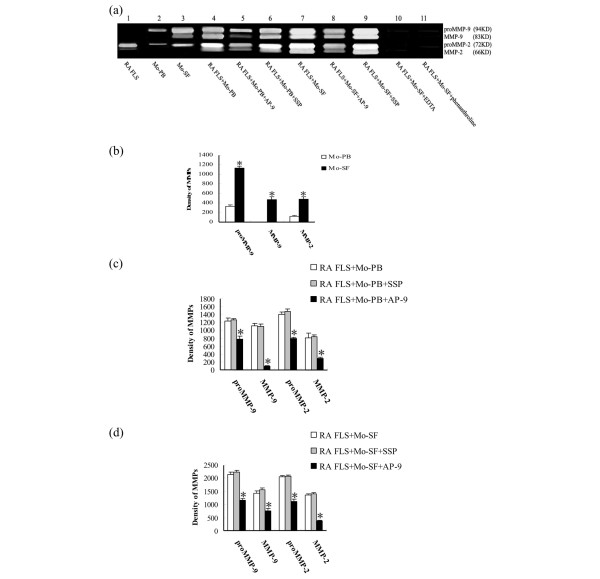
Gelatin zymography of culture medium conditioned by fibroblast-like synoviocytes (FLS) and monocytes/macrophages. Cells were cultured in serum-free media for 24 hours, and the conditioned media were collected and analyzed for matrix metalloproteinase (MMP) activity by gelatin zymography. (a) Secretion and activation of MMPs in rheumatoid arthritis (RA) FLS, monocytes/macrophages, RA FLS co-cultured with monocytes/macrophages, and in co-cultured cells treated by AP-9 or SSP, and ethylenediamine tetraacetic acid or phenanthroline. Top two bands, MMP-9 gelatinase; lower two bands, MMP-2 gelatinase. (b) The value of proMMP-2 and MMP-2 activity of monocytes from peripheral blood of healthy humans (Mo-PB) was lower than monocytes/macrophages from synovial fluid of RA patients (Mo-SF) (n = 10, P < 0.05). (c) The value of proMMP-9, MMP-9, proMMP-2 and MMP-2 activity of RA FLS co-cultured with Mo-PB was higher than that of co-cultured cells treated by AP-9 (n = 6, P < 0.05), while no inhibitory effects were found in irrelevant peptide SSP (n = 6, P > 0.05). (d) The value of proMMP-9, MMP-9, proMMP-2 and MMP-2 activity of RA FLS co-cultured with Mo-SF was higher than that of co-cultured cells treated by AP-9 (n = 6, P < 0.05), while no inhibitory effects were found in irrelevant peptide SSP (n = 6, P > 0.05). Values are the means ± standard error (n = 6–10). *P < 0.05 (experimental groups versus control groups).